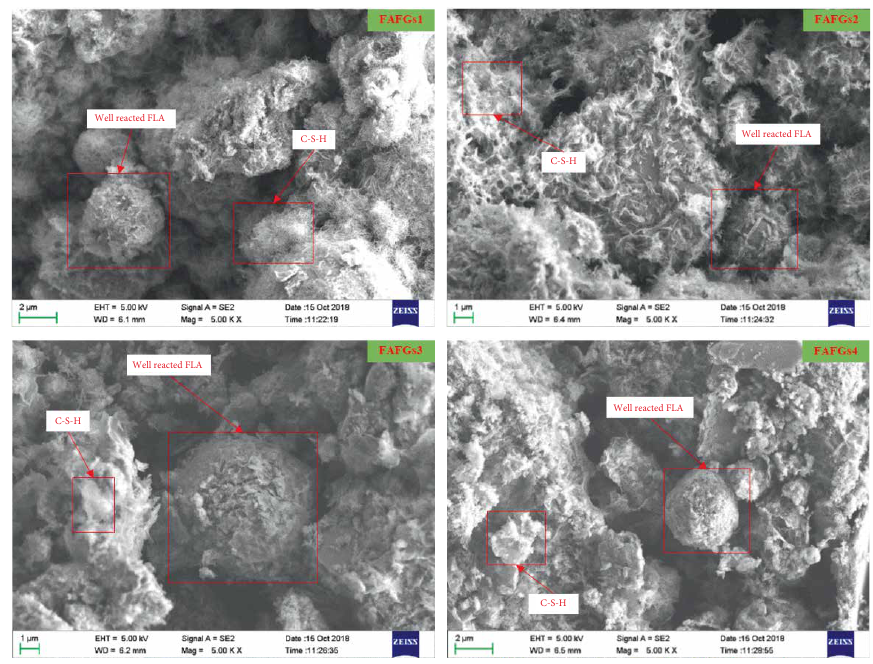
Figure 8: SEM result for reaction extent of